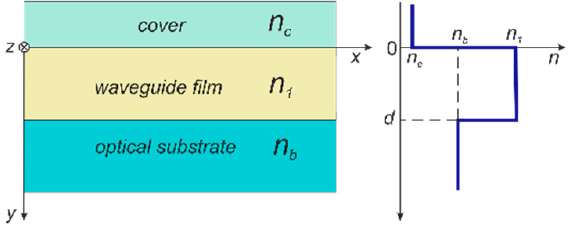
Figure 3. Scheme of the optical slab waveguide and its refractive index profile.